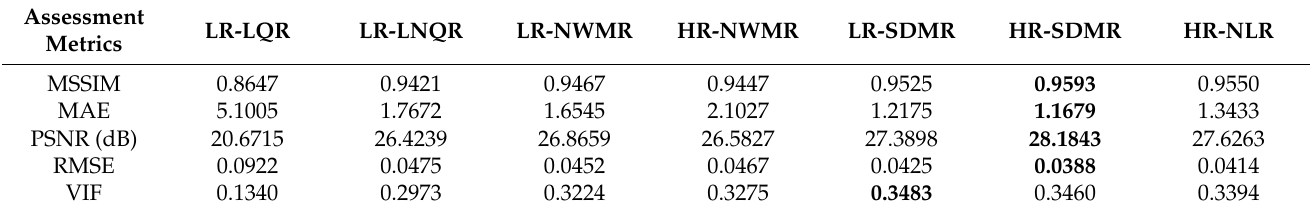
Table 2. Quantitative performance comparison of reconstructions using five different image quality assessment metrics. The bold values indicate the best results.